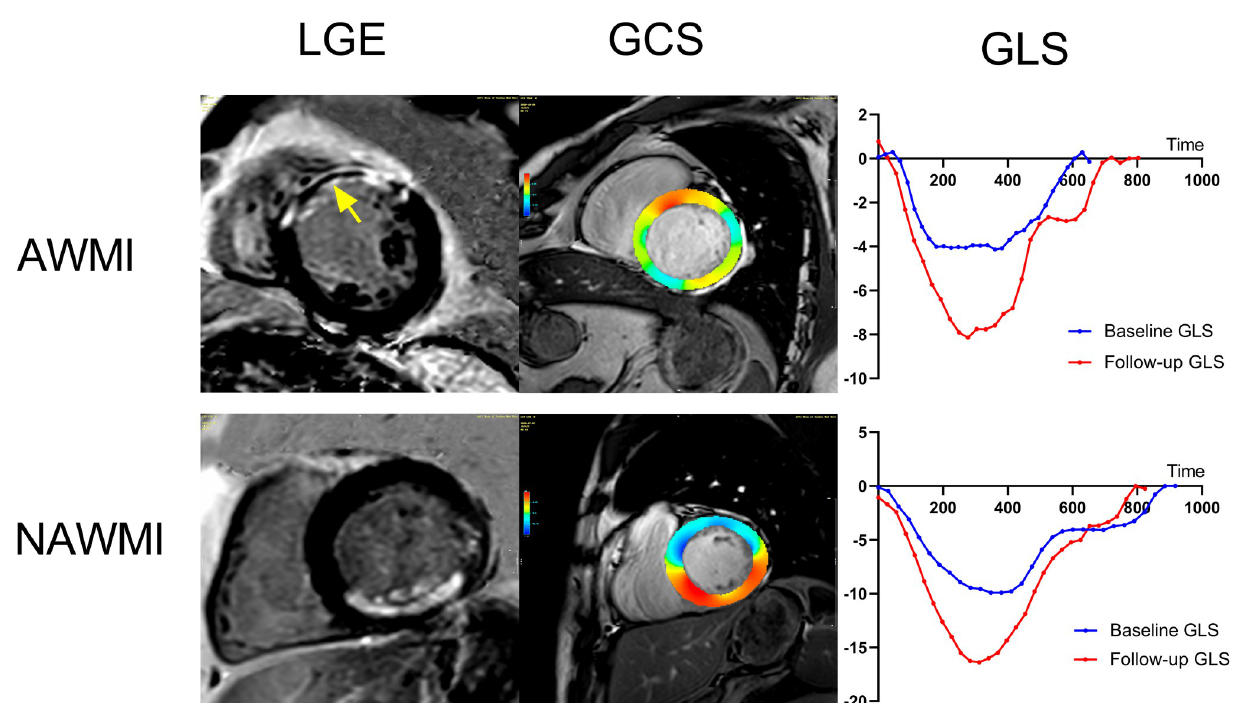
Fig 1. Cardiac magnetic resonance (CMR)-late gadolinium enhancement (LGE) and feature tracking (FT). First line: LGE-CMR reveals anterior wall myocardial infarction (AWMI) with microvascular obstruction (yellow arrow). Second line: LGE-CMR reveals inferior wall myocardial infarction. Pseudo-colored images showed globe circumferential strain (GCS) of the infarcted myocardium was significantly decreased (red part). Globe longitudinal strain (GLS) curves derived from CMR-FT analysis displayed the values of baseline and follow-up global peak systolic longitudinal strains,